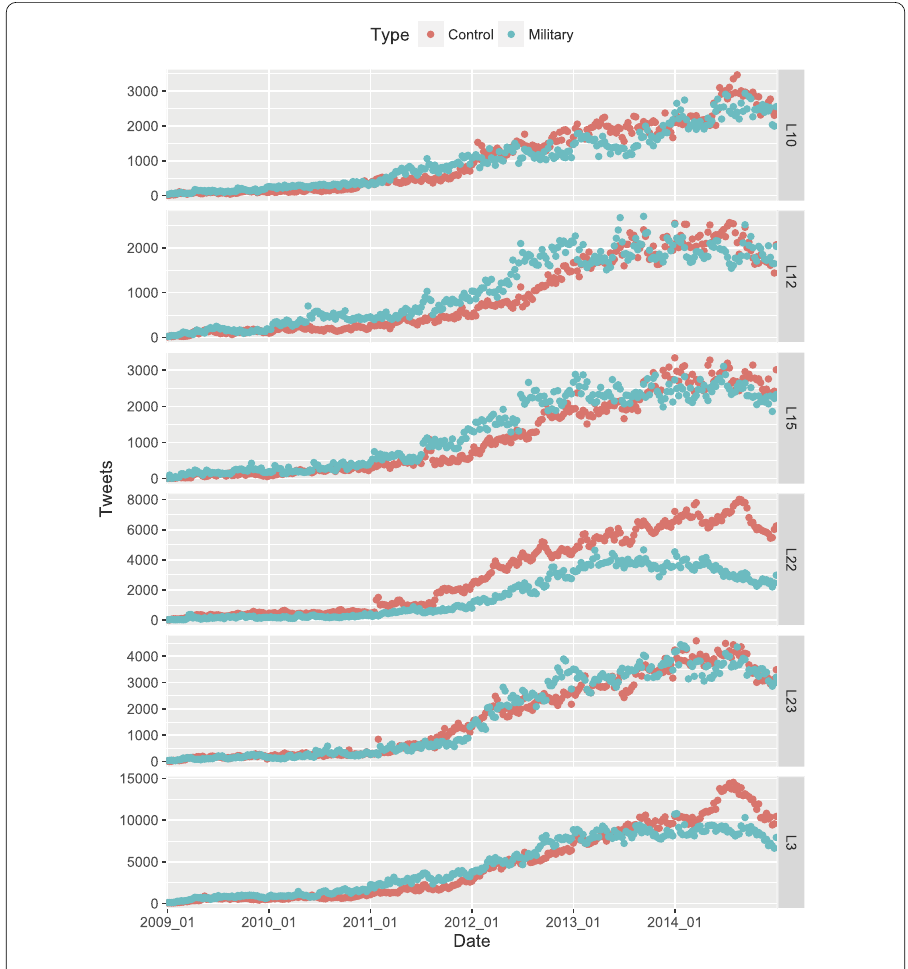
Figure 3 Military and control tweets per from 01/2009 to 12/2014 across six geolocations. Weekly number of tweets vary across locations and over time e.g., between 2009-2011 the number of weekly tweets is significantly lower than between